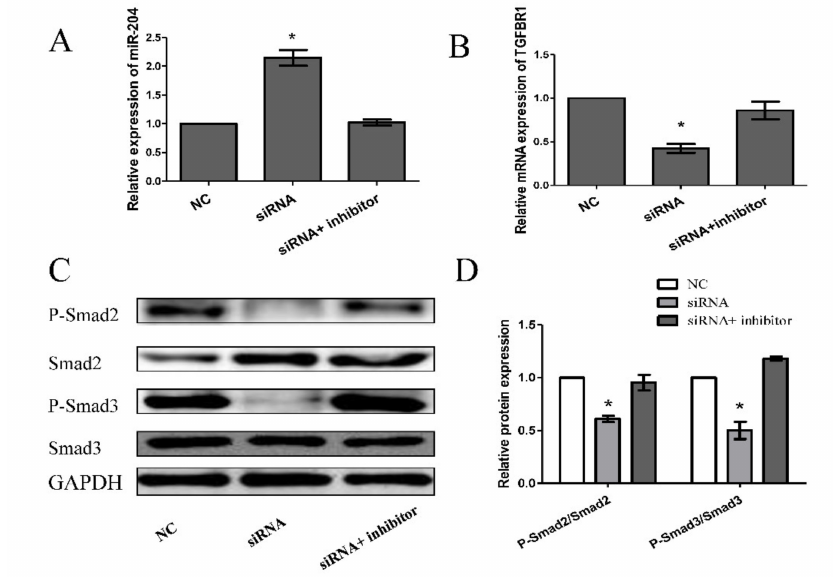
Figure 5. Knockdown of FDNCR1 promotes preadipocyte di ff erentiation through the TGF- β signaling pathway. ( A , B ) Expression of miR-204 and TGFBR1 after transfection with FDNCR1 siRNA and / or a miR-204 inhibitor. ( C , D ) Protein levels of p -Smad2 / Smad2 and p -Smad3 / Smad3 after transfection with FDNCR1 siRNA and / or a miR-204 inhibitor. “*” indicates significance.